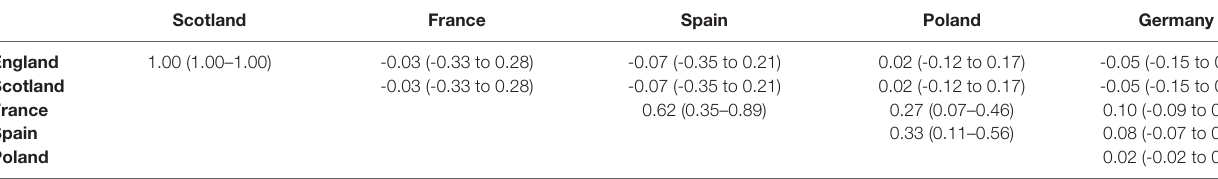
TABLE 5 | Agreement in reimbursement status between countries for metabolic drugs.